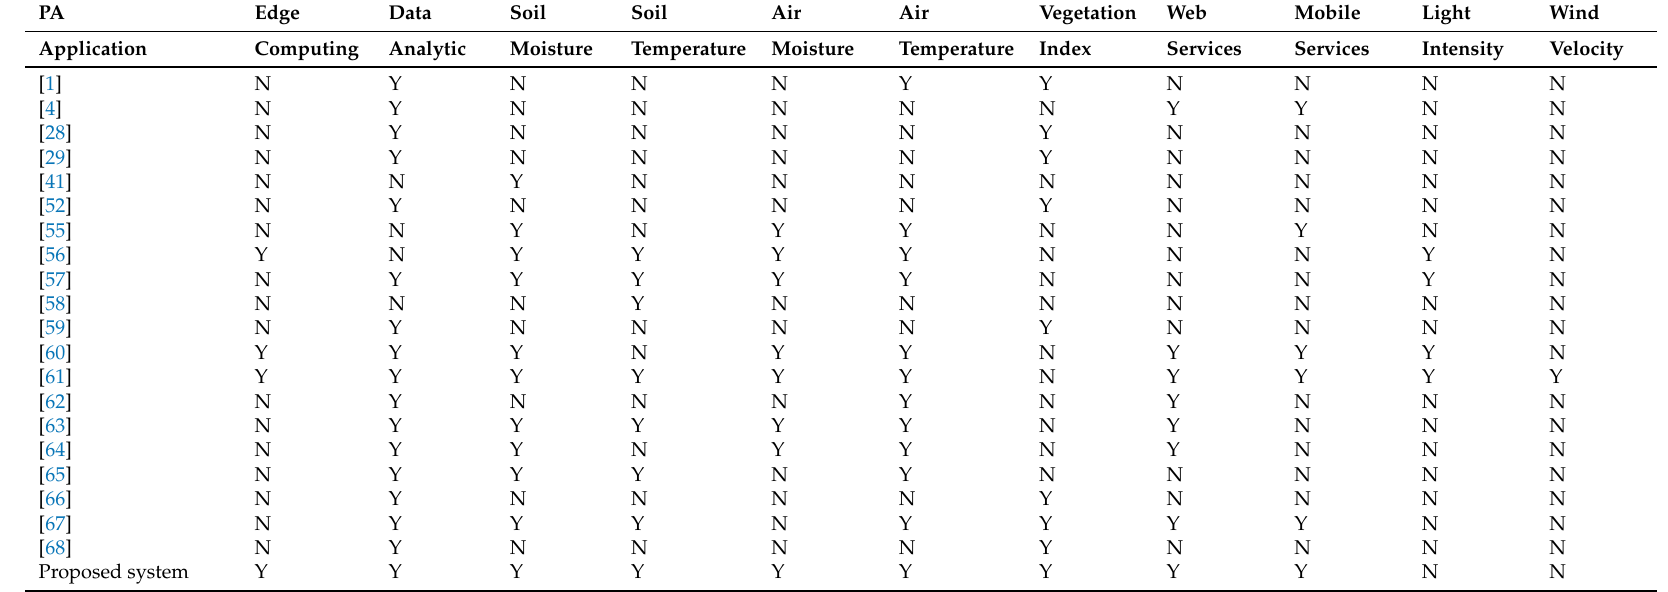
Table 8. Comparison among existing PA